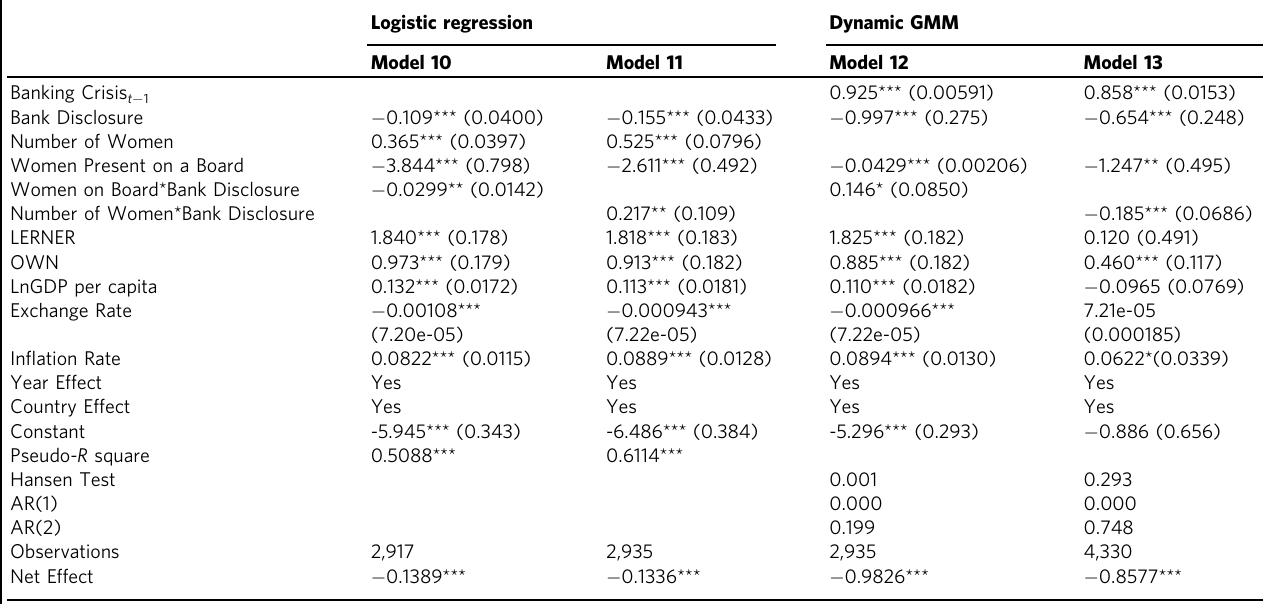
Table 6 Interaction Effect of board gender diversity on the relationship between bank disclosure and banking